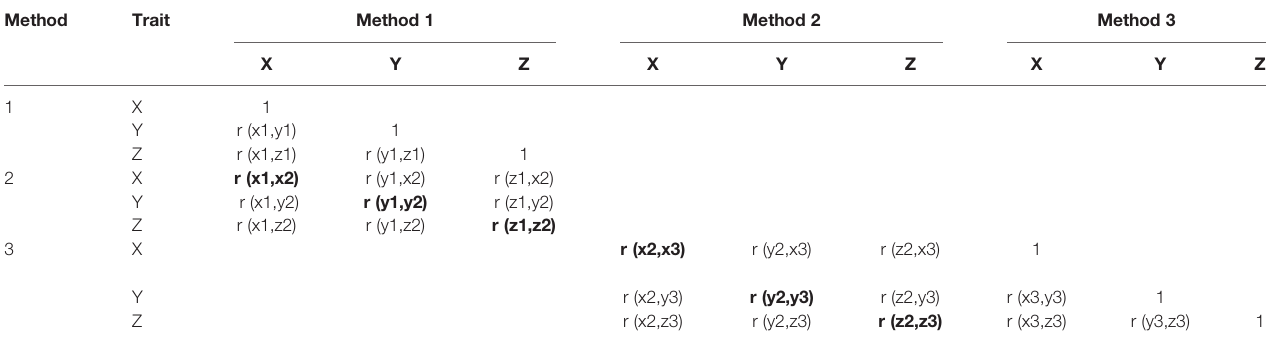
TABLE 1 | Example Multitrait-Multimethod Correlation